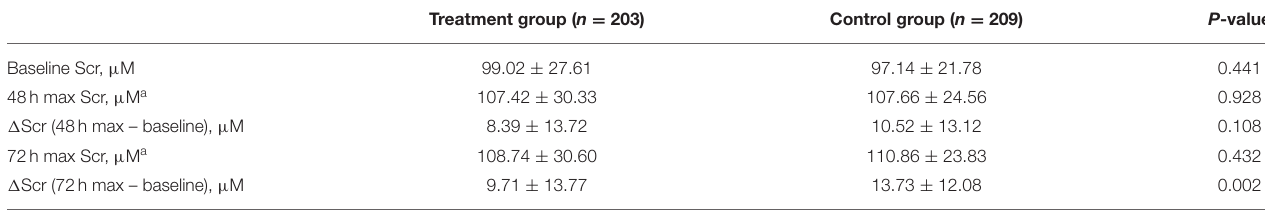
TABLE 2 | Change in serum creatinine concentration from pre-PCI baseline to 48h and 72 h after the initiation of PCI in two